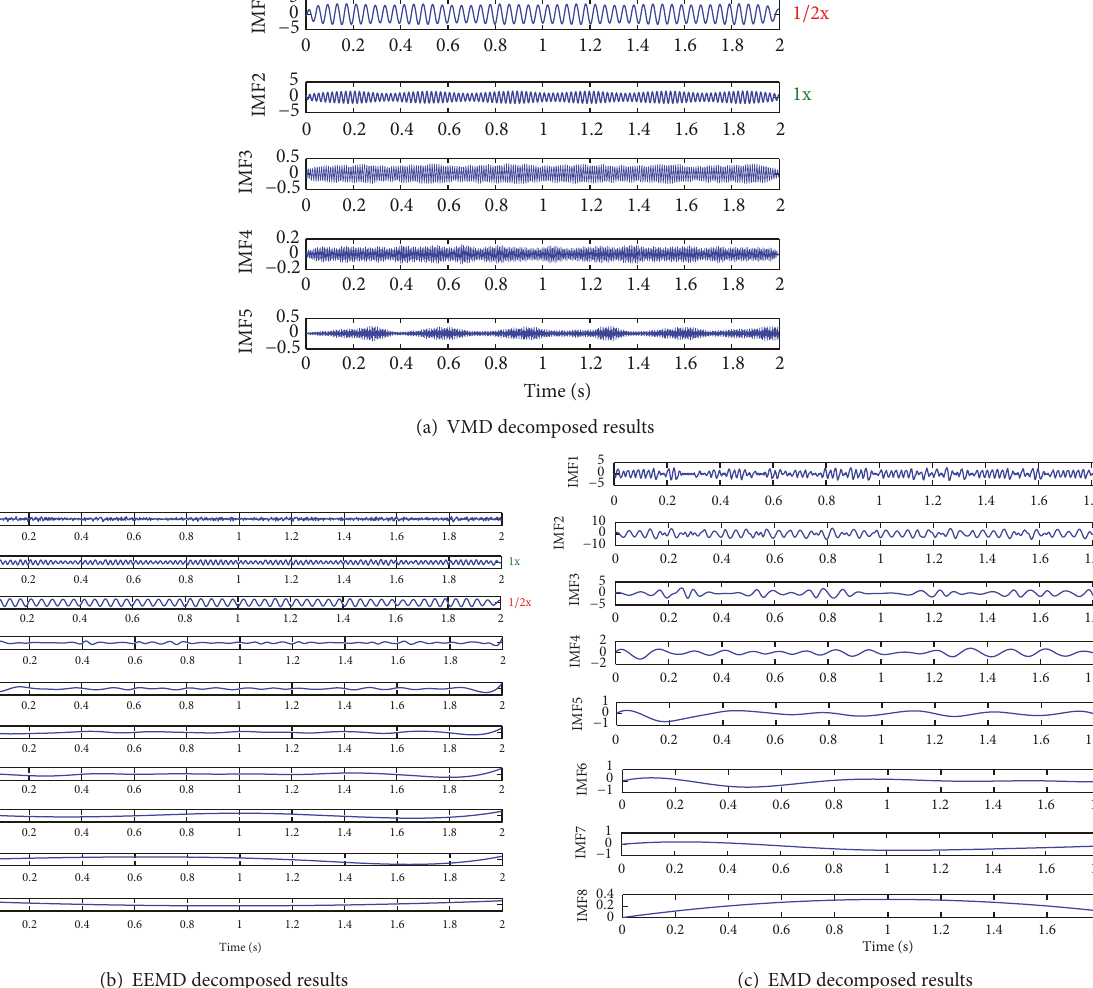
Figure 7: VMD, EEMD, and EMD decomposed results of oil whirl